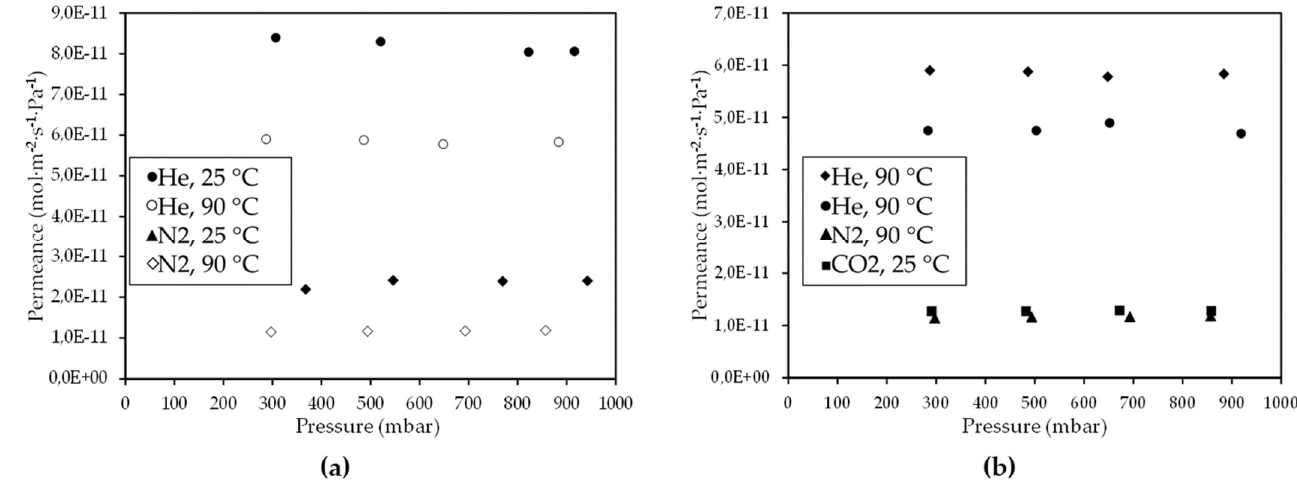
Figure 4. Permeance of ( a ) He, N 2 , CO 2 , and SF 6 gases at 25 °C and ( b ) CO 2 gas at 25, 50, and 90 °C, through the CΜ_3 membrane, with respect to the pressure.